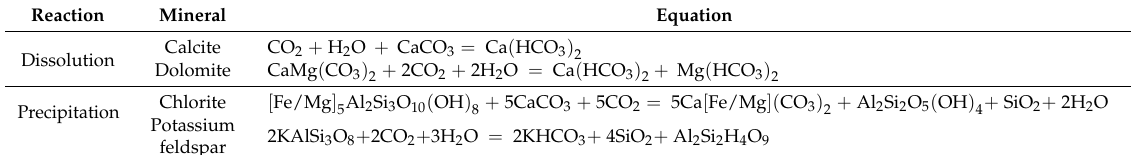
Table 1. Chemical reactions of various minerals in carbonic acid in the initial reaction